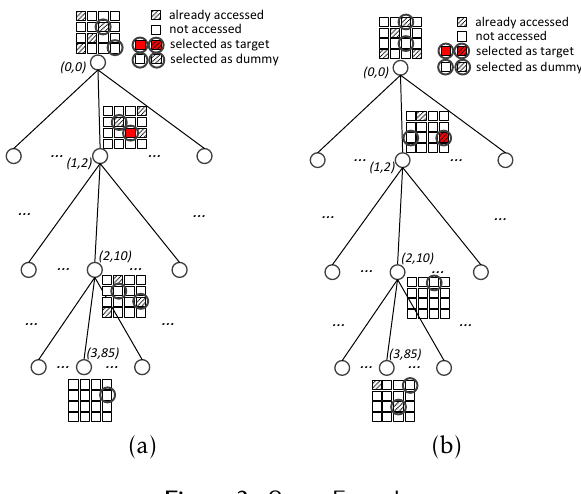
Figure 3. Query Examples.